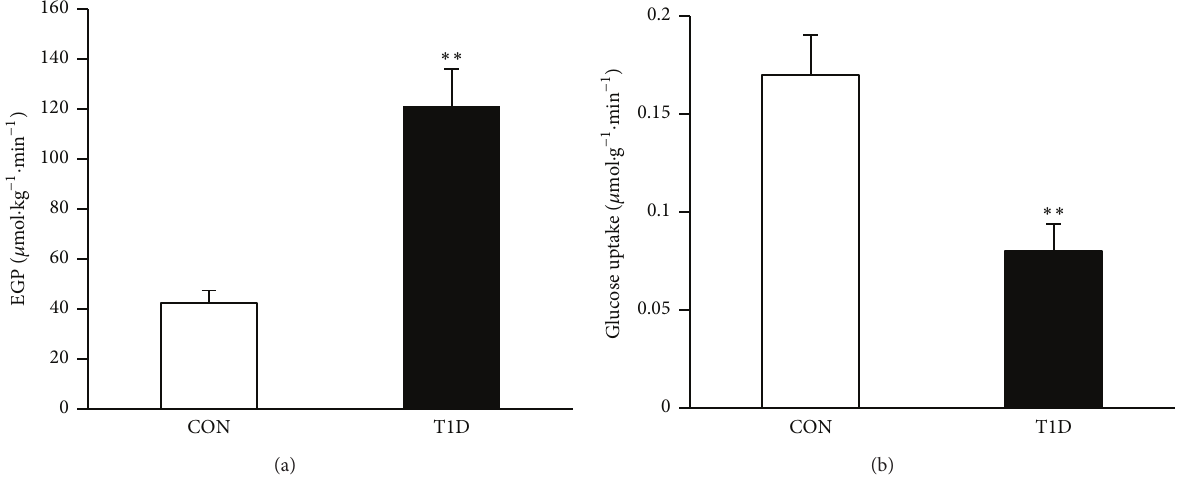
Figure 3: Measurement of fasting endogenous glucose production (EGP, (a)) and skeletal muscle glucose uptake (b) in type 1 diabetic and nondiabetic rats. ∗∗ 𝑃 < 0.01 between the two groups.